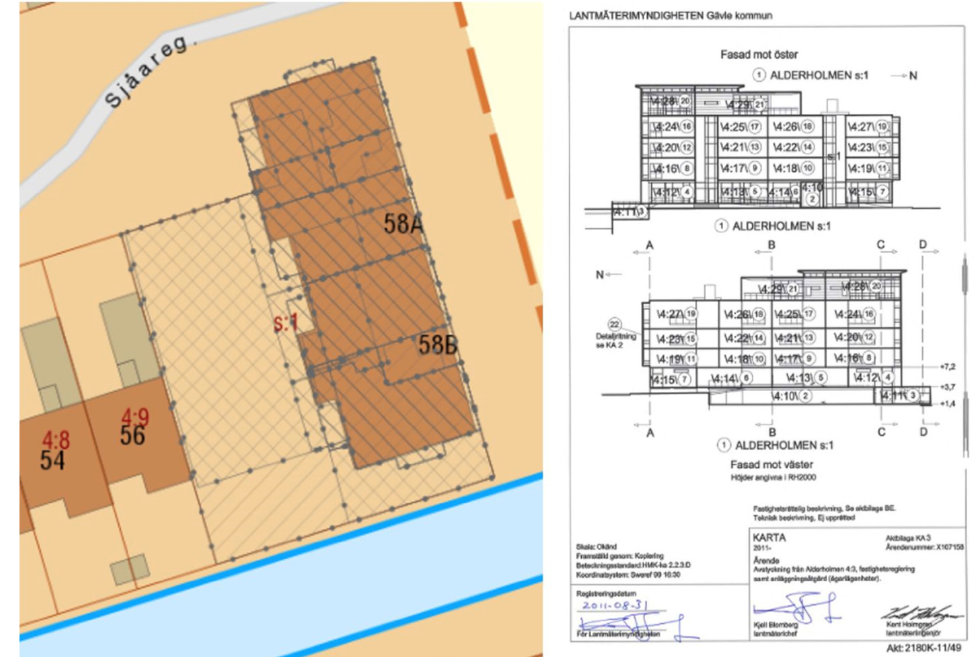
Figure 1. Illustration from the Swedish Digital Cadastral Index Map showing ownership apartments ( left ) and cadastral plans of the same properties ( right ) [1].